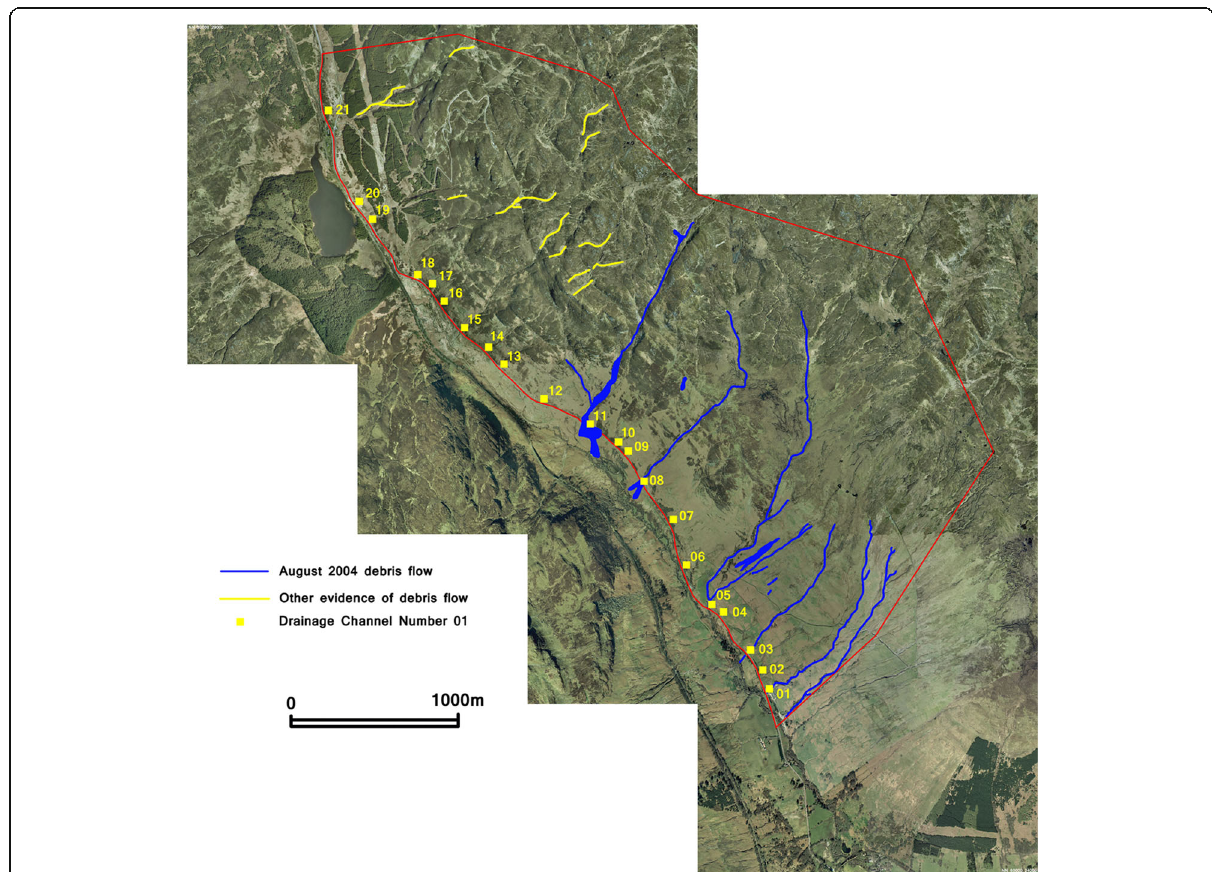
Fig. 9 Debris flow events with known locations and signs of instability determined from the aerial photography. Locations of the drainage channels at the A85 Glen Ogle as confirmed by field reconnaissance are also shown. Base aerial photography reproduced by permission of